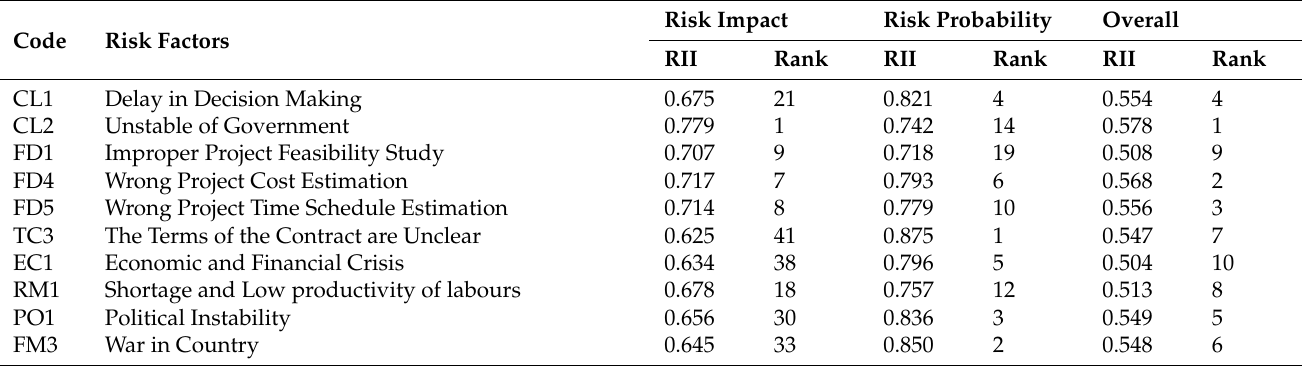
Table 7. The RII for the cause of risk factors